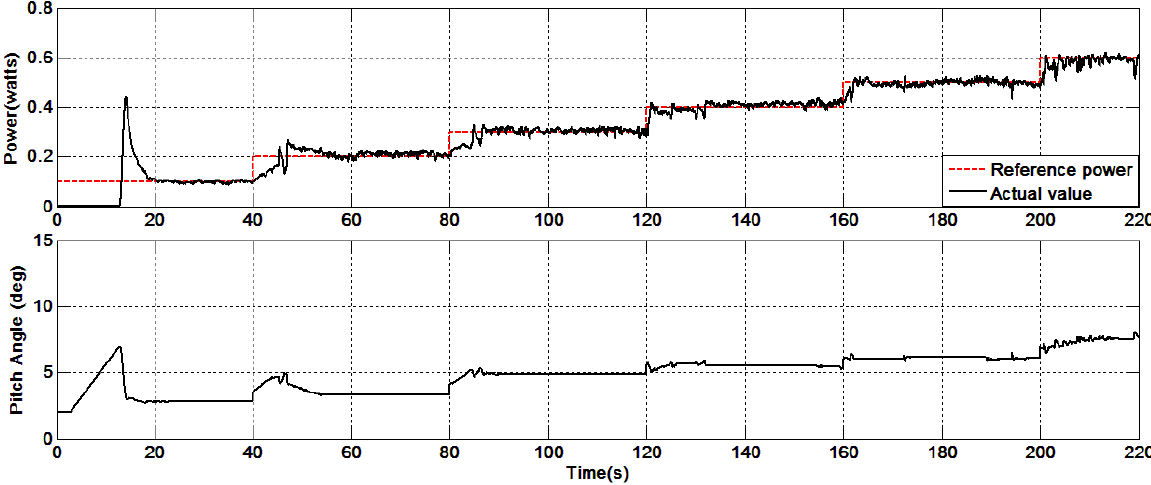
Figure 13. Generated power and pitch angle under PI fluctuation controller.